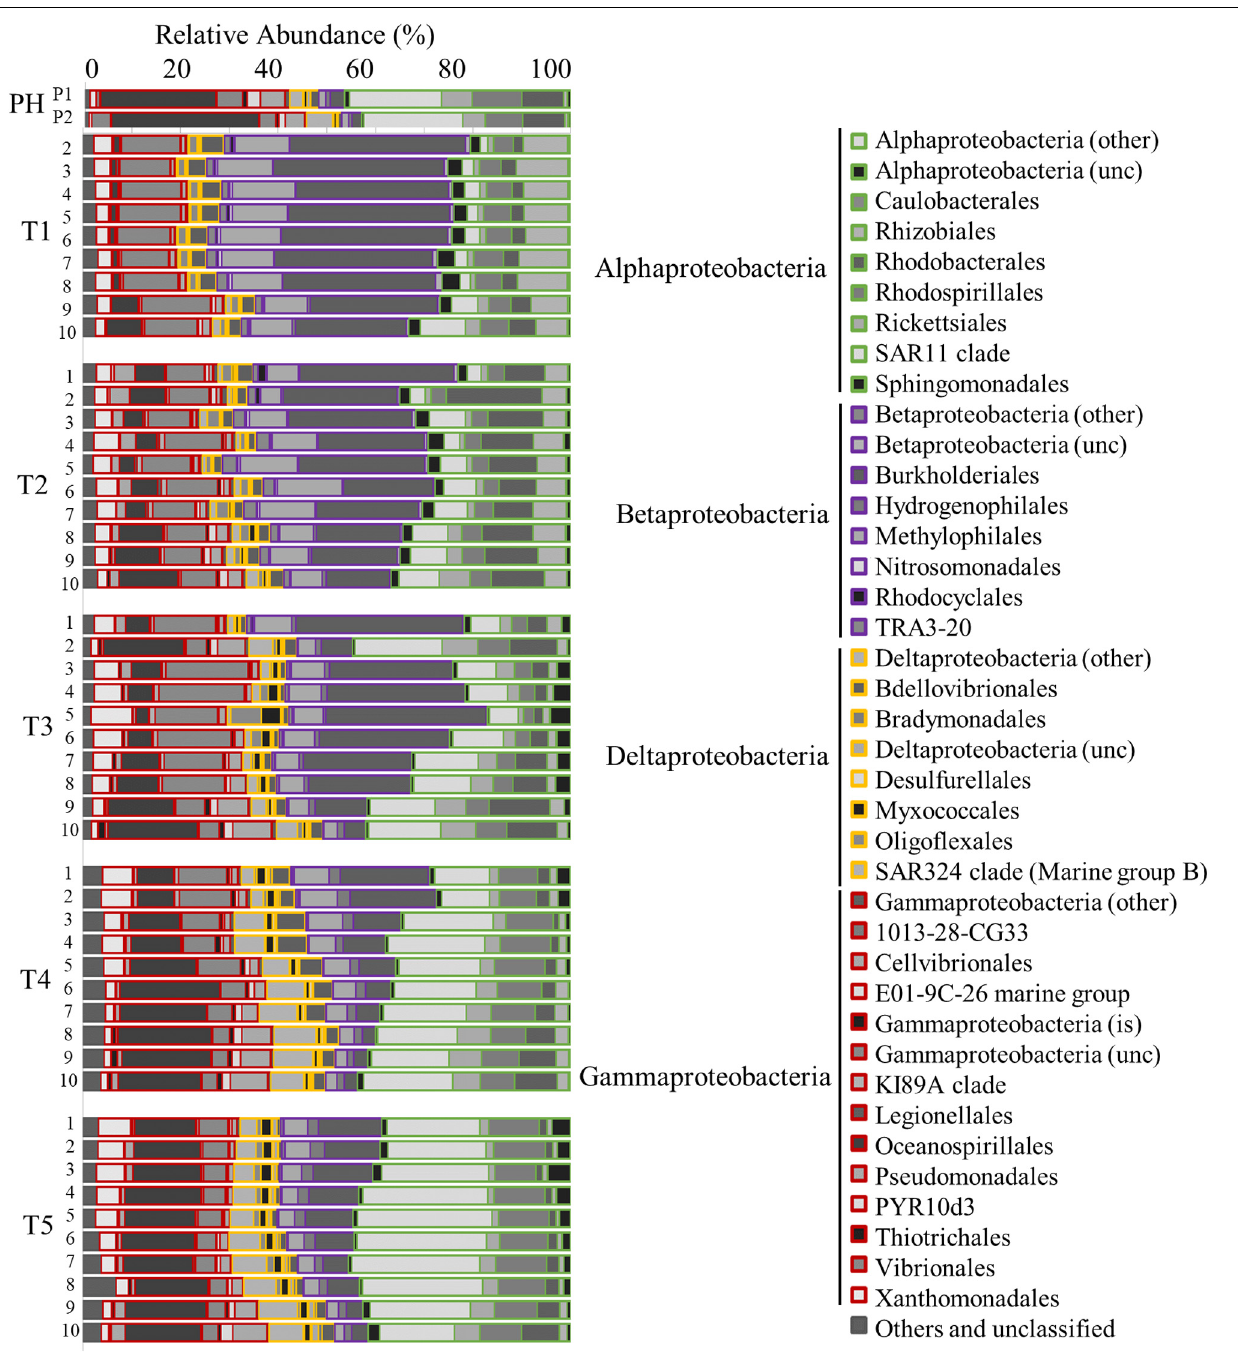
FIGURE 6 | Bar graph showing the relative abundance of OTUs for the Proteobacteria community identified by 16s rRNA analysis. Time points are separated into blocks (T1–T5). Within each time point block, each bar represents the relative abundance for the members of the bacteria community at each station (1–10). The phyla are indicated by differing border color on the bar graphs [incertae sedis (is) and unclassified (unc)]. P1 and P2 are pre-Harvey samples from 07/31/17 and 08/22/17,